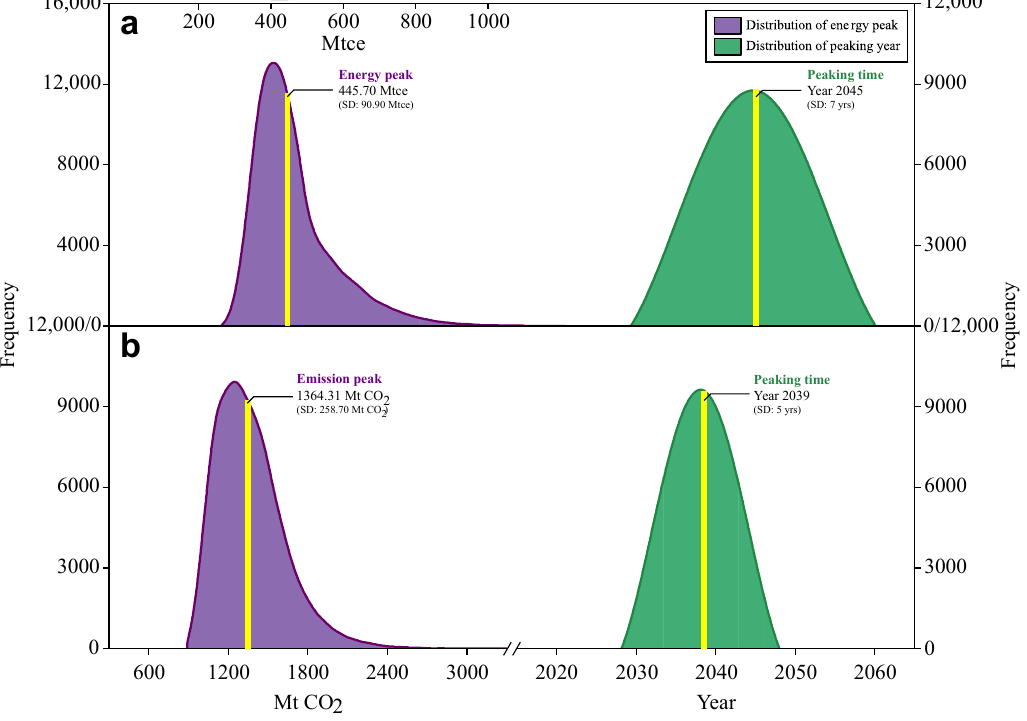
Figure 5. Distributions of ( a ) energy peak status and ( b ) emission peak status in future commercial building operations.